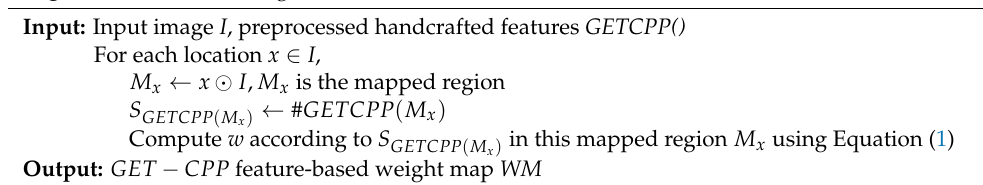
Algorithm 1: Backtracking and GETCPP feature extraction.